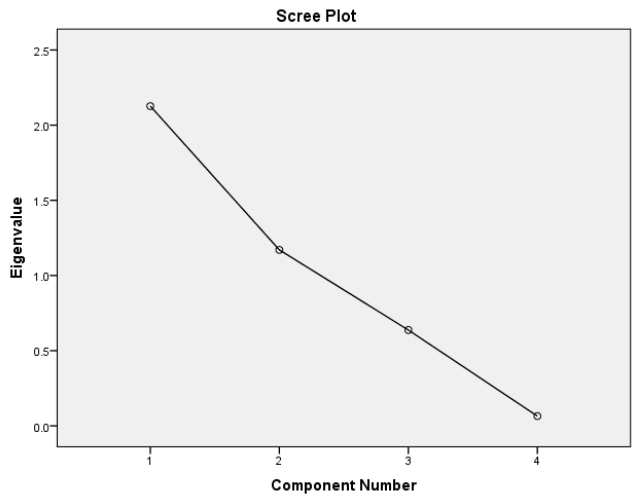
Figure 4. Sedimentation graph of the competence of Originality and Innovation. Source: Authors.